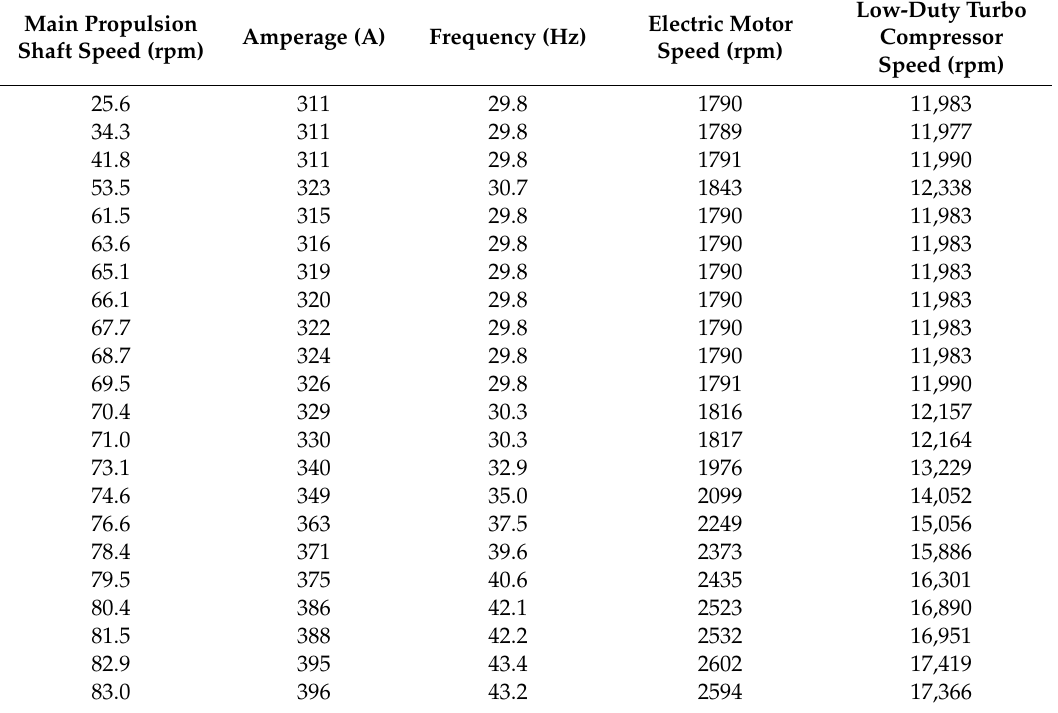
Table 3. Measured values for current, frequency and power